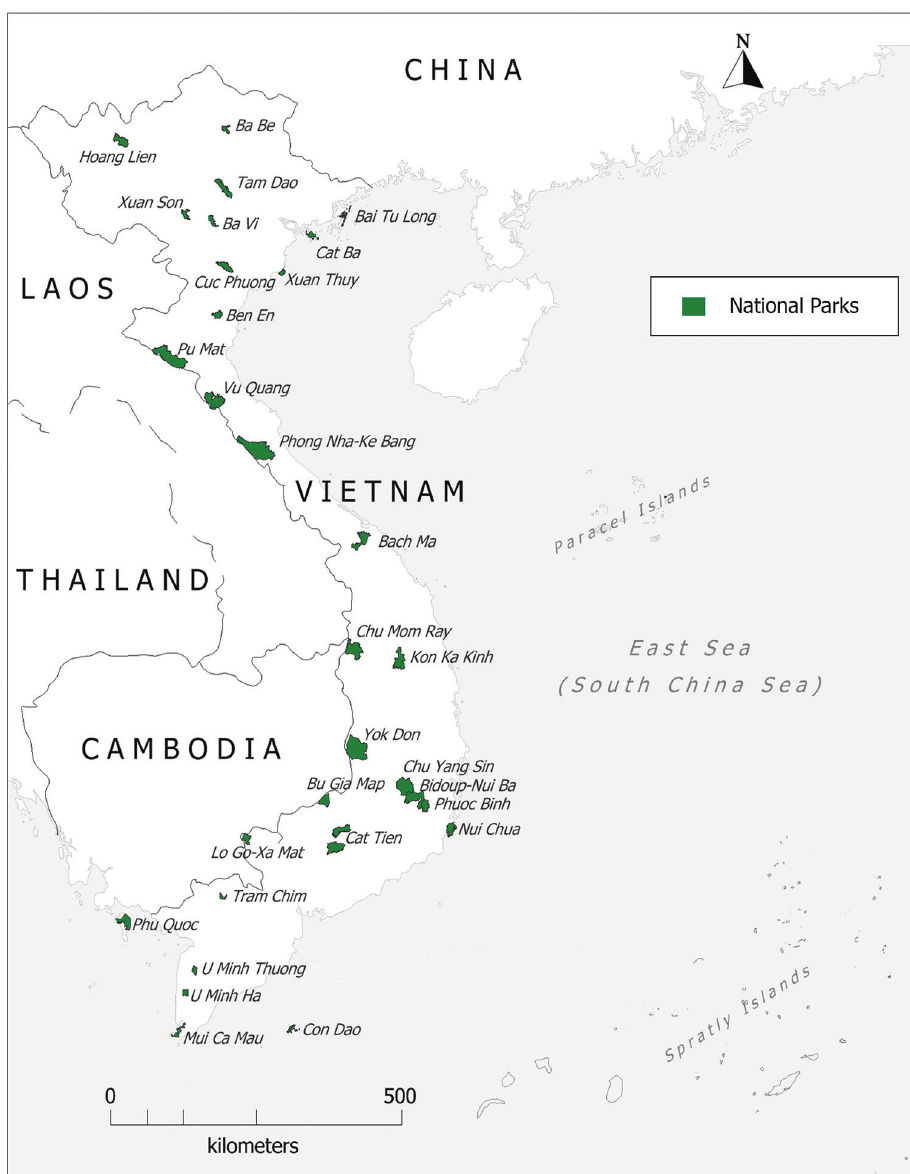
Figure 1. Distribution of the thirty national parks, Vietnam. Source: Adapted to IUCN and UNEP- WCMC